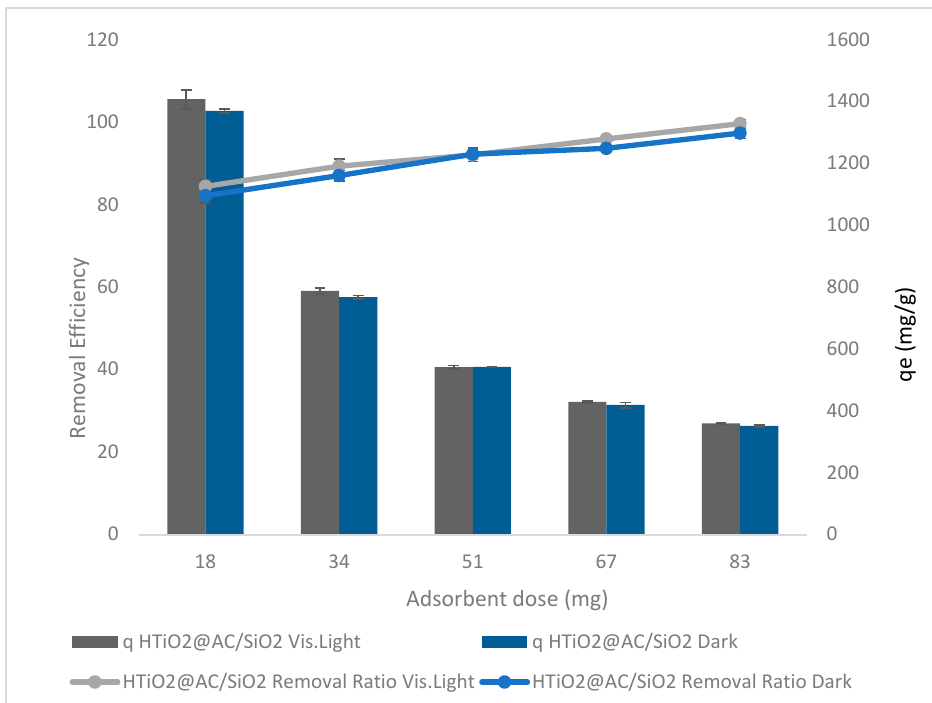
Figure 7. The effect of HTiO 2 @AC/SiO 2 doses in dark and visible light on oxamyl removal. The results of using HTiO 2 @AC/SiO 2 in dark and visible light are shown in Figure 7. The oxamyl removal ratio gradually increased from 82% to 97% (r 0.98, p 0.002) and 84.5% to 99.7% (r 0.99, p 0.0002) in dark and visible light, respectively, with a rise in HTiO 2 @AC/SiO 2 dose from 18 to 83 g L − 1 . Increased HTiO 2 dosage may improve oxamyl removal due to increased surface area accessibility [20].